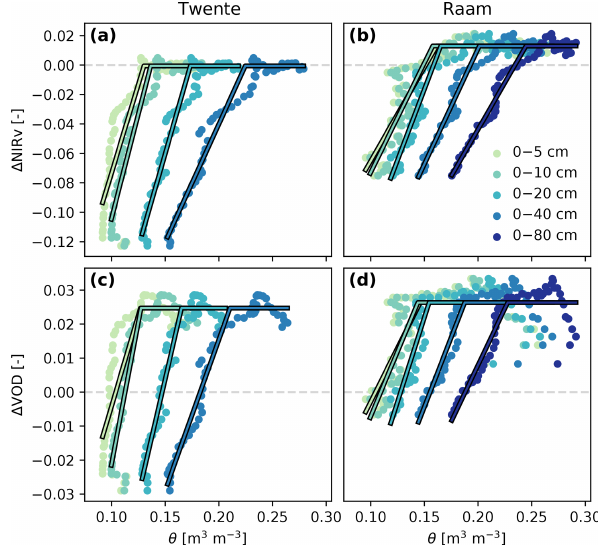
Figure 3. Relation between regional anomalies in vegetation in- dices and soil moisture (dots) and the piecewise linear fit (lines) for Twente (a, c) and Raam (b, d) , for both NIRv (a, b) and VOD (c, d) . The horizontal part of the piecewise fit was set at the average veg- etation index anomaly value in the first part of the summer period (corresponding to the horizontal line in Fig. 2a and b). Note that all values represent average values over the regions, as shown in Fig. 2.